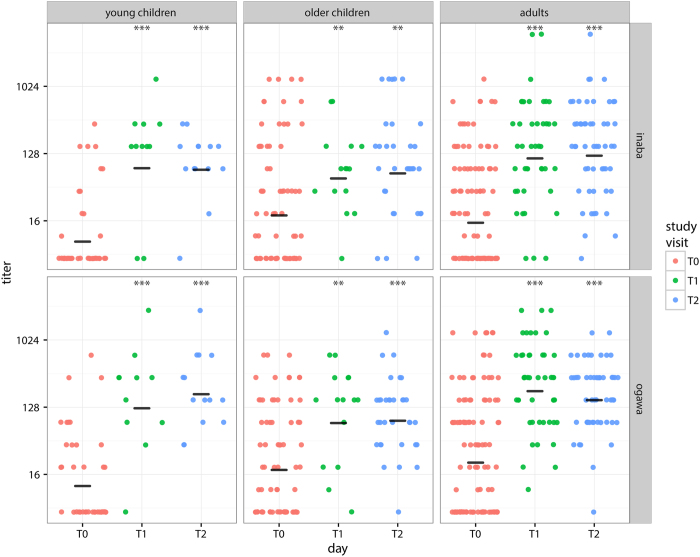
Vibriocidal titer by study visit (color), age-group (columns) and serotype (rows).Geometric mean titer (GMT) shown with black horizontal line in each. Asterisks represent p-values from tests comparing the GMT from baseline (T0) to either T1 or T2, two asterisks (**) represents p ≤ 0.01 and three asterisks (***) represents p ≤ 0.001.